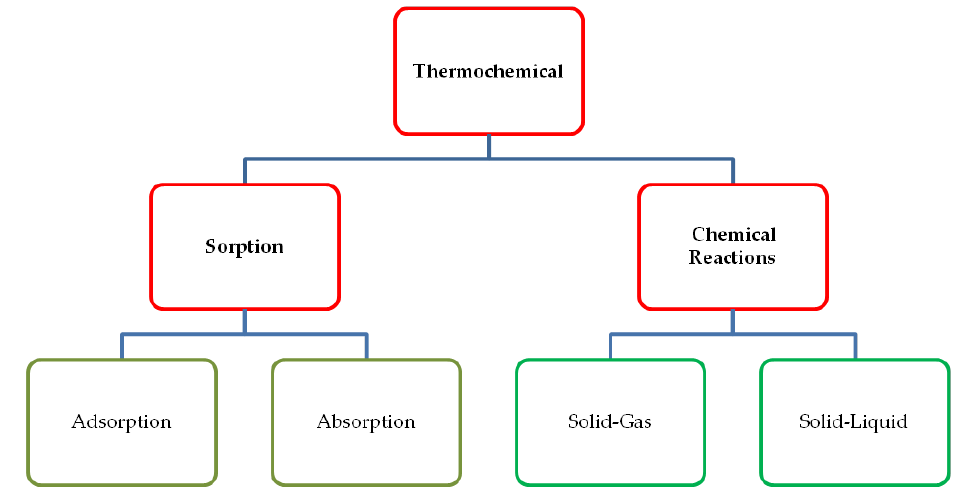
Figure 2. Thermochemical Heat Storage principles classification